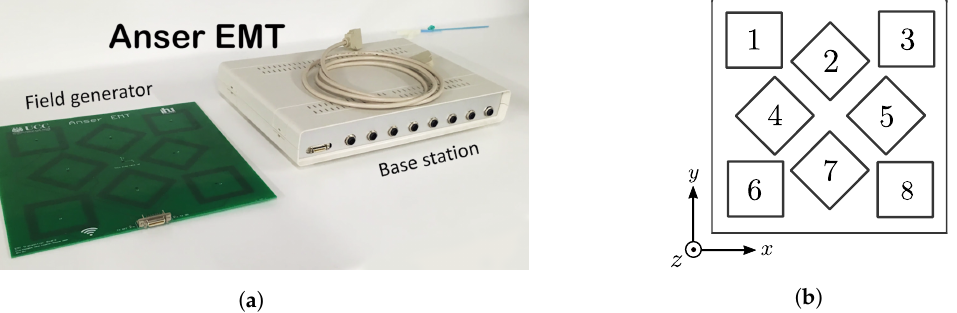
Figure 2. ( a ) The Anser electromagnetic tracking system [17]. ( b ) The arrangement of coils on the Anser EMT transmitter. This arrangement was originally based on an optimised coil placement by